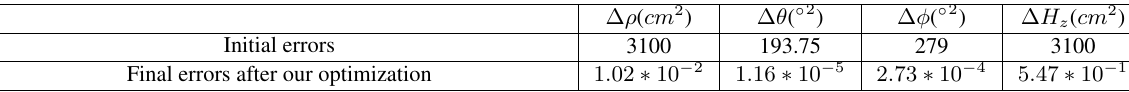
Figure 10. Evolution of the energy of synthetic point cloud #1. In blue, we show the evolution of our energy during the optimization; in red, this is the number of paired points at each iteration for our optimization method